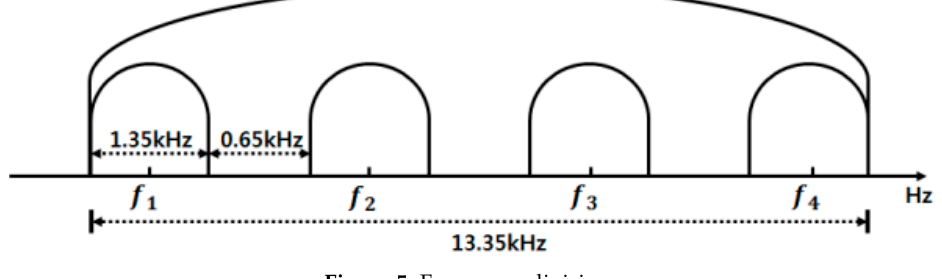
Figure 5. Frequency division.